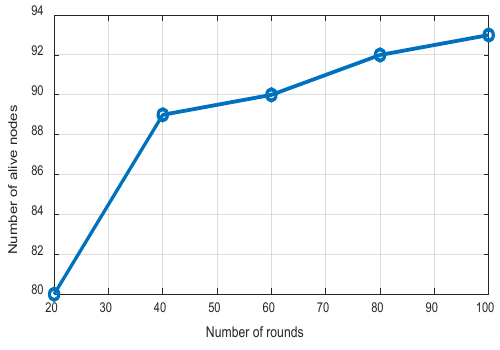
Figure 5. No. of Alive Nodes present in the network for proposed Protocol